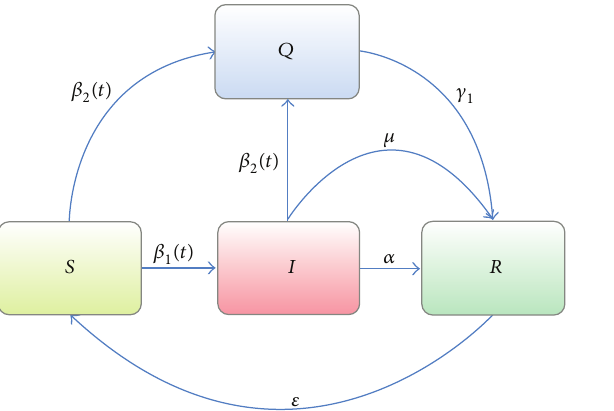
Figure 10: State transition of passive